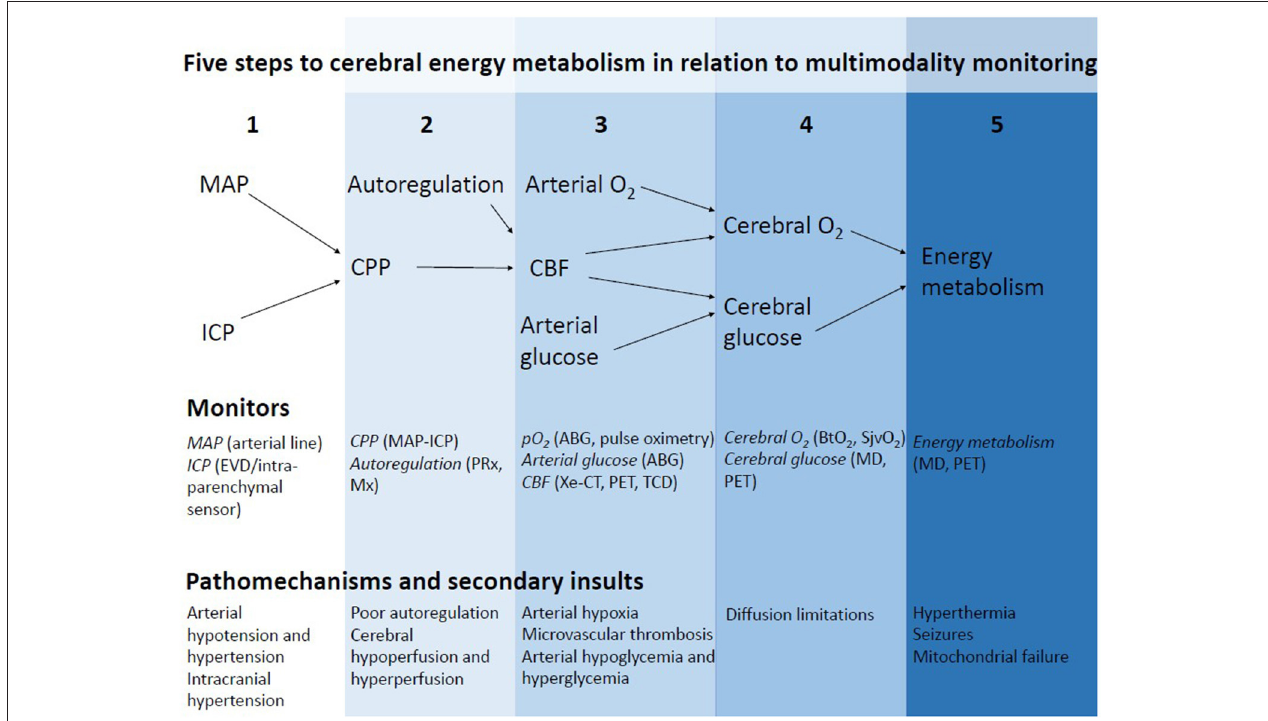
FIGURE 1 | Five critical steps in the pathway to cerebral energy metabolism in relation to multimodality monitoring. By monitoring all the steps in this pathway to achieve sufficient cerebral energy metabolism, energy failure may be detected in time and the correct diagnosis can be made. Treatments should aim at counteracting the specific mechanism that causes cerebral energy metabolic